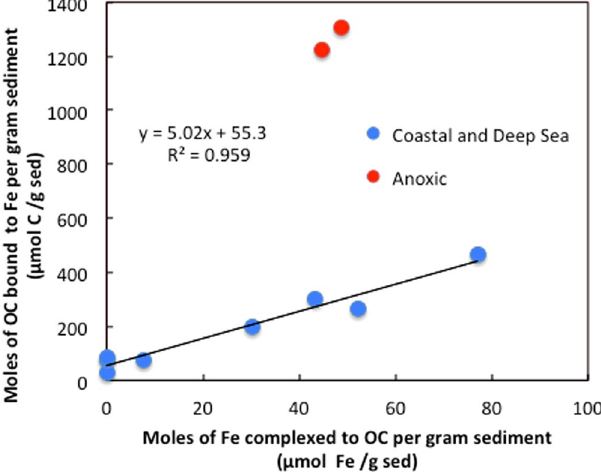
Figure 6. Correlation between the quantity of OC associated to iron oxides measured by wet chemical extraction 7 , and the quantity of Fe found complexed to OC measured by XANES (this work) for the samples studied in this work. Sediments accumulating under anoxic conditions are excluded from the regression (see text for